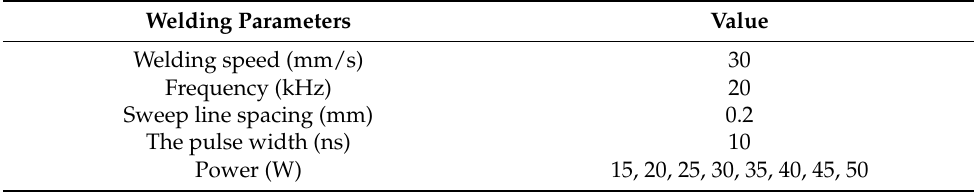
Figure 1. Schematic diagram of the laser welding. Table 3. Nanosecond pulse laser welding parameters. Table 3. Nanosecond pulse laser welding parameters.